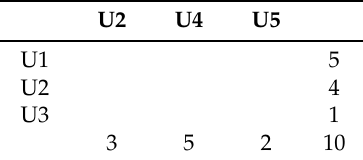
Table 4. Example of contingency table obtained in one